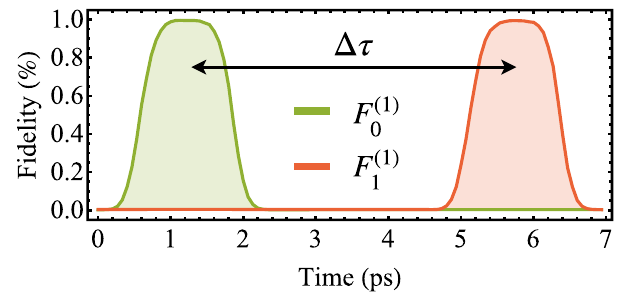
FIG. 4. Pump-delay measurements. Measurement of the state fidelity for the time basis, i.e., F ( 1 ) (solid green curve) and F ( 1 ) 0 1 (solid red curve). The arrow shows the time-bin separation, or bin width, (cid:2)τ . The shape of the fidelity curve as a function of the pump delay is dictated by the pulse duration of the pump and signal and by the difference in group velocity of the pump and signal inside the SMF.